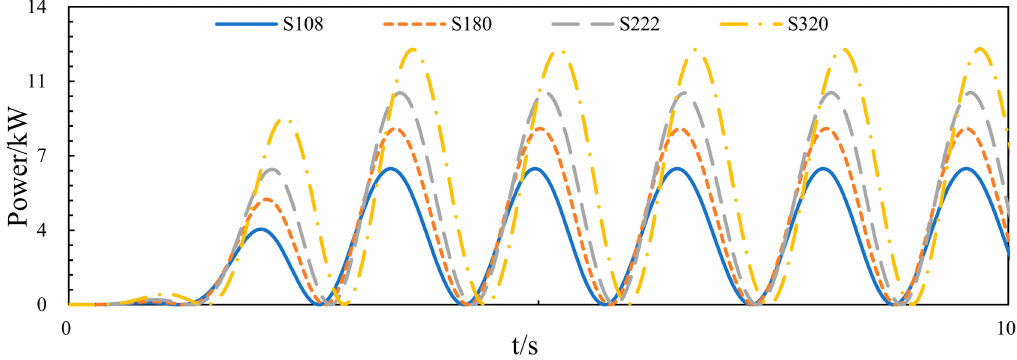
Figure 12. The instantaneous power curves of Buoy 2.